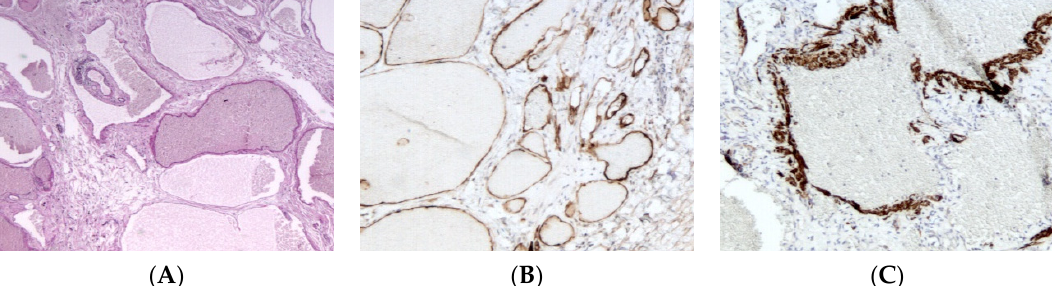
Figure 4. Lymphatic malformation. ( A ), (H.E.S). Collection of large interconnected lymphatic cisterns. Small lymphoid aggregates are also present (at the upper left quarter). ( B ), (D2 ‐ 40). Positive cytoplasmic immunostaining of endothelial cells. ( C ), (smooth muscle actin). Positive cytoplasmic immunostaining of disorganized smooth muscle in the wall of larger channels.